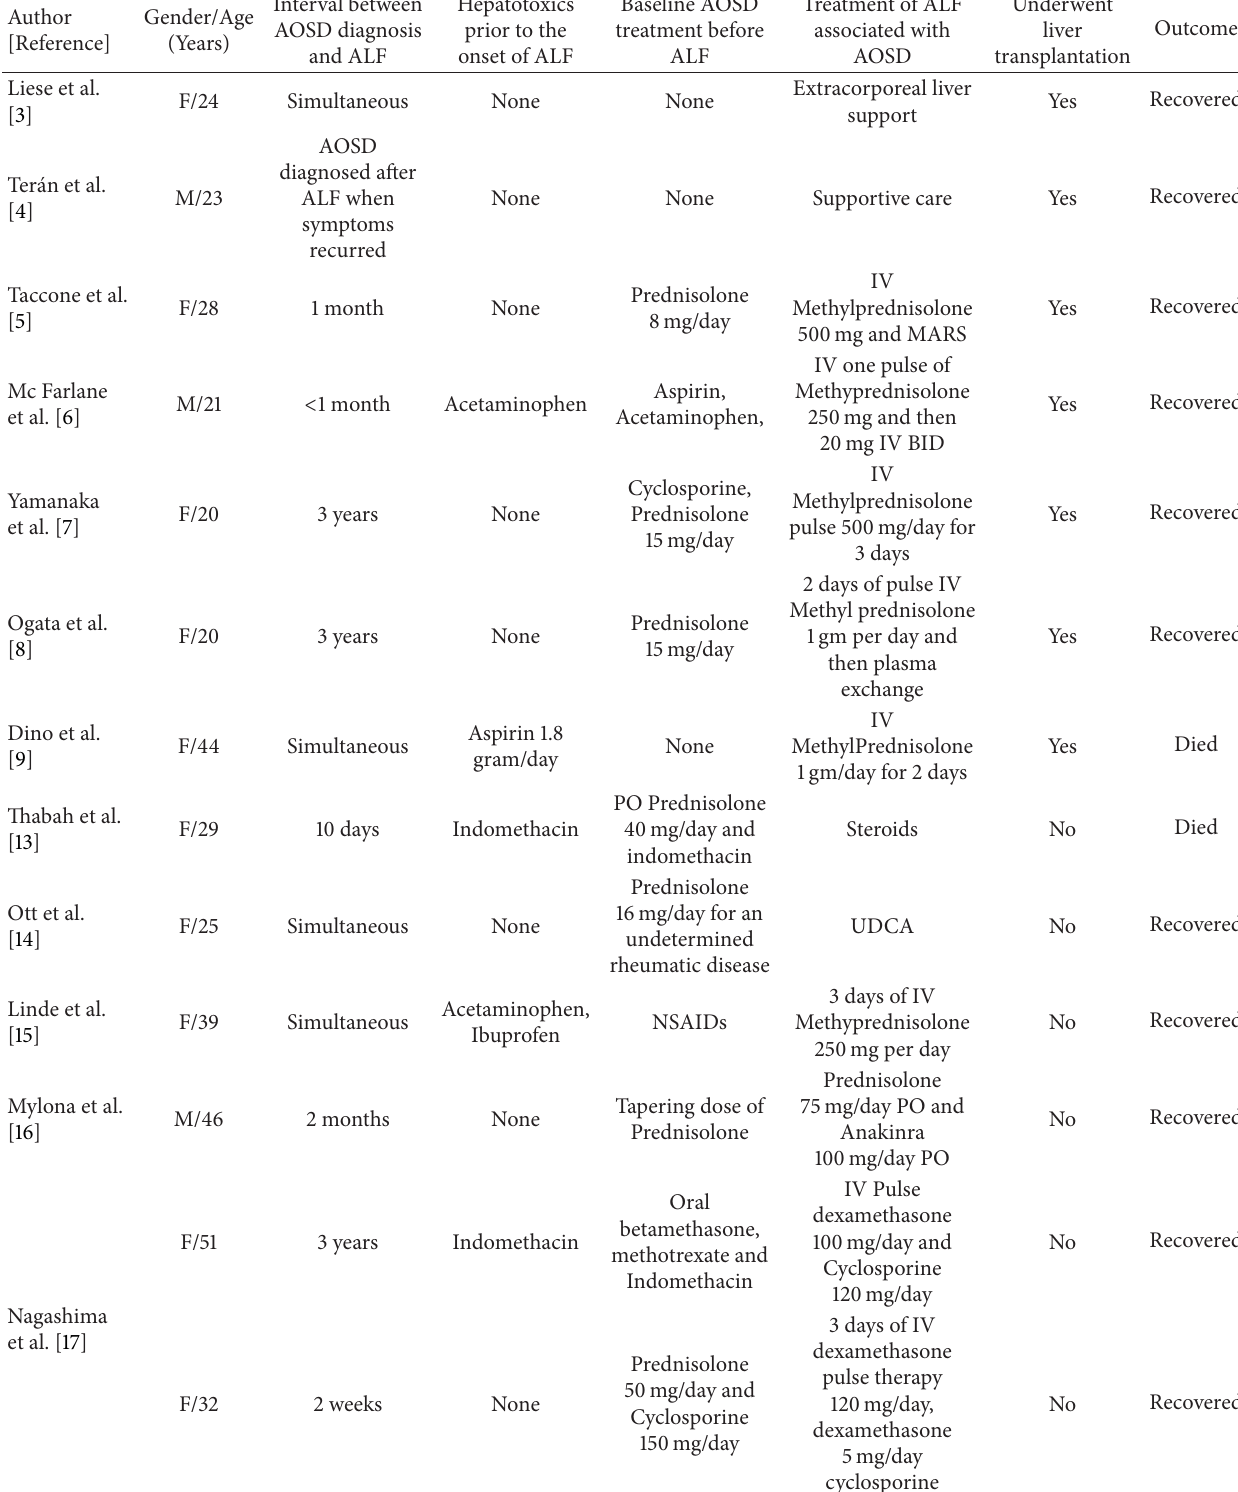
Table 1: Characteristics of cases reported on ALF in Adult Onset Still’s Disease